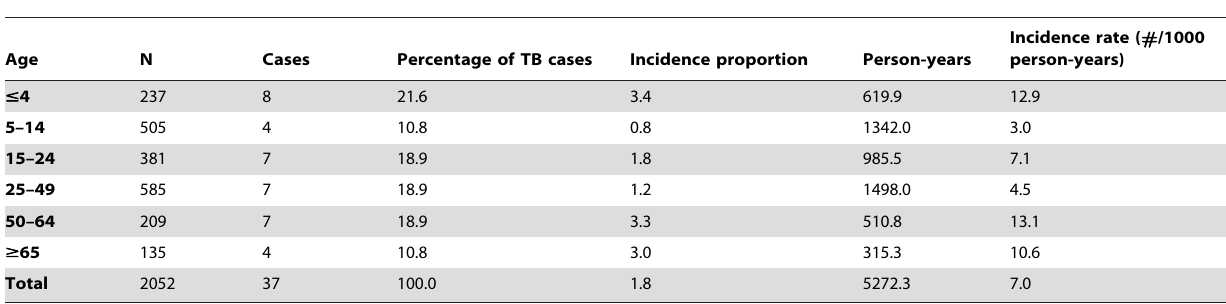
Table 4. Incidence of active tuberculosis in household contacts according to age.